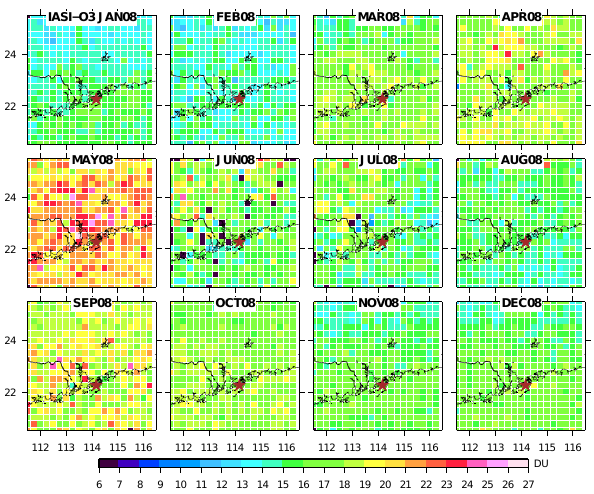
Fig. 11. Same as Fig. 8 for Hong Kong.